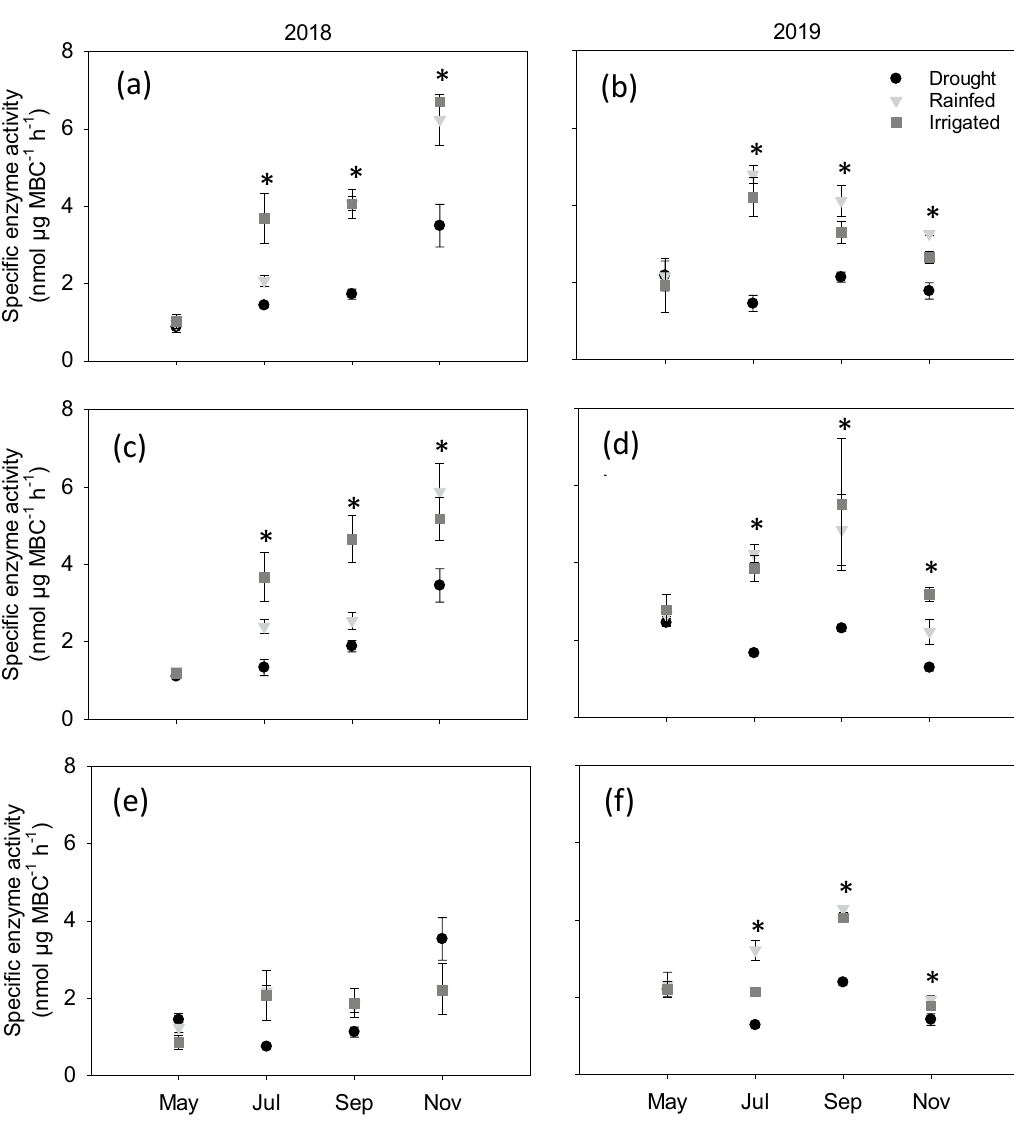
Figure 7. Specific enzyme activity under drought, rainfed, and irrigated treatments at 0–5 ( a , b ), 5–15 ( c , d ) and 15–30 ( e , f ) cm depths during 2018 and 2019. Asterisk represents statistical significance at p ≤ 0.05 at each time point. No asterisks mean no statistical significance. Error bars represent standard error (n = 3). Sampling in May represents baseline and in November represents post shelter